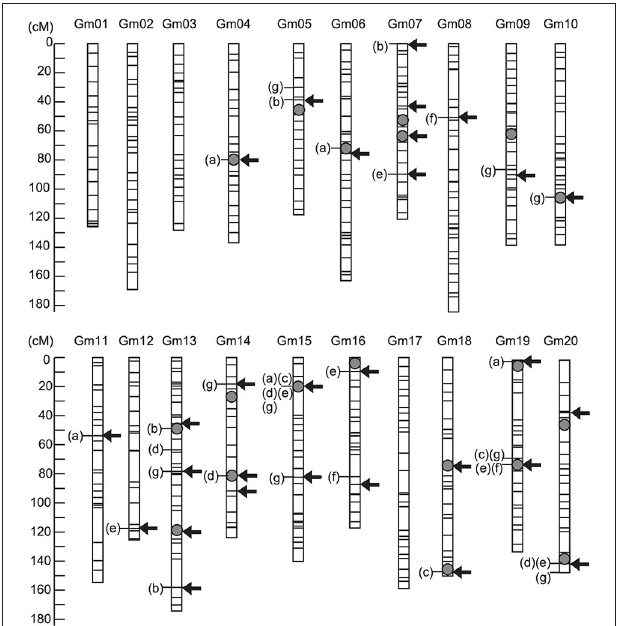
FIGURE 4 | Genetic map locations of genetic factors controlling seed protein content. The arrows indicate marker positions used to construct the prediction model of protein content. The grey circle indicates the quantitative trait locus (QTL) positions detected using multienvironment multiple interval mapping (ME-MIM) analysis. The letters in parentheses show the name of yearly data set for which significant association of the marker with protein content was detected using a variational method for Bayesian hierarchical regression (VBAY): (a) NICS1-2009, (b) NICS2-2010, (c) WARC-2011, (d) WARC-2012, (e) NICS3-2012, (f) NICS3-2012L, and (g) NICS3-2013.